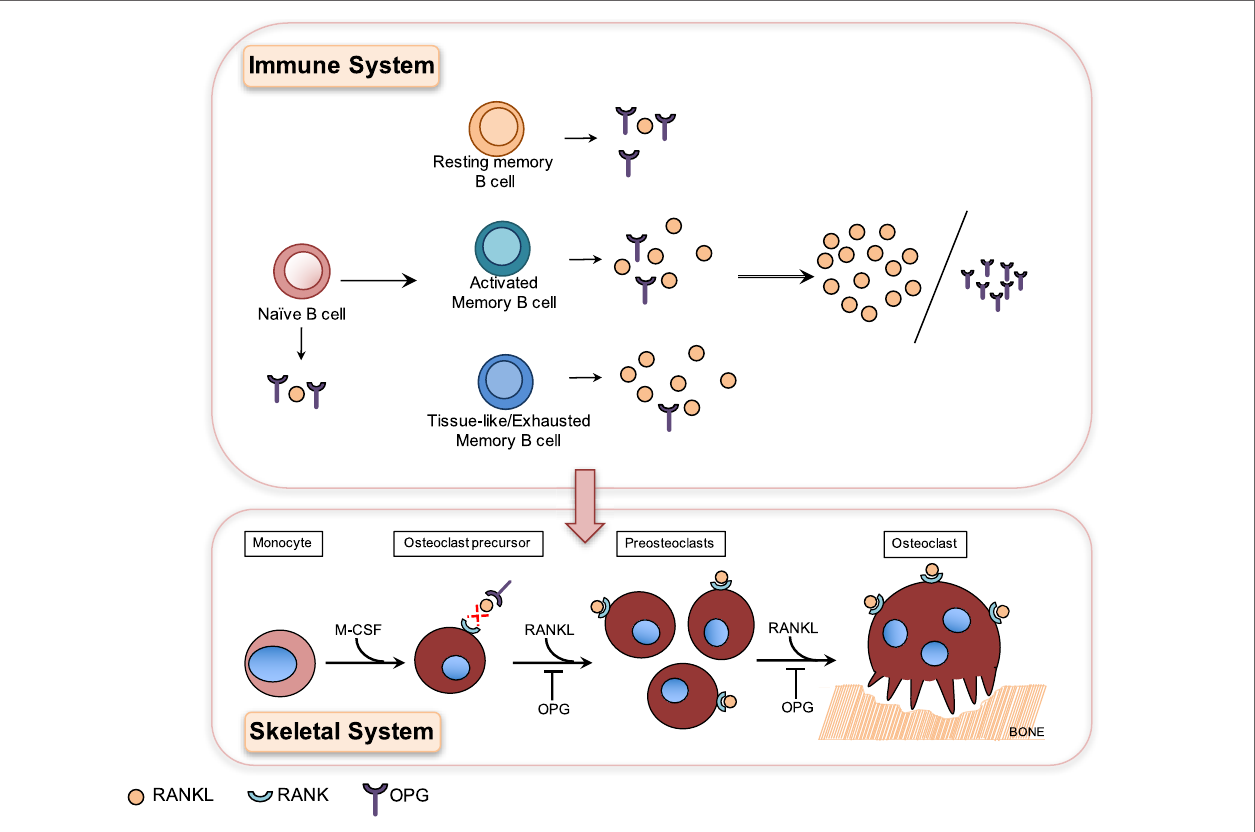
FiGuRe 2 | Differential production of osteoprotegerin (OPG) and receptor-activator of NF- κ B ligand (RANKL) by B cell subsets results in higher RANKL/OPG ratio, which contributes to HIV-induced osteoclastogenesis and bone loss. Osteoclasts are generated in a process known as osteoclastogenesis, which is driven by the key osteoclastogenic cytokine RANKL. Osteoclasts originate from cells of the myeloid lineage, which in the presence of M-CSF and RANKL differentiate into receptor-activator of NF- κ B (RANK)-expressing pre-osteoclasts, which proliferate and fuse to form giant multinucleated osteoclasts capable of resorbing bone. HIV infection leads to the depletion of resting memory B cells and expansion of activated B cell subsets including activated memory and tissue-like memory B cells. Resting memory B cells produce the highest amounts of OPG and tissue-like memory B cells conversely the lowest amounts of OPG and the highest amounts of RANKL (26). HIV-induced B cell subset changes therefore translate into higher RANKL/OPG ratios, which contribute to increased osteoclastogenesis and bone loss in HIV-infected